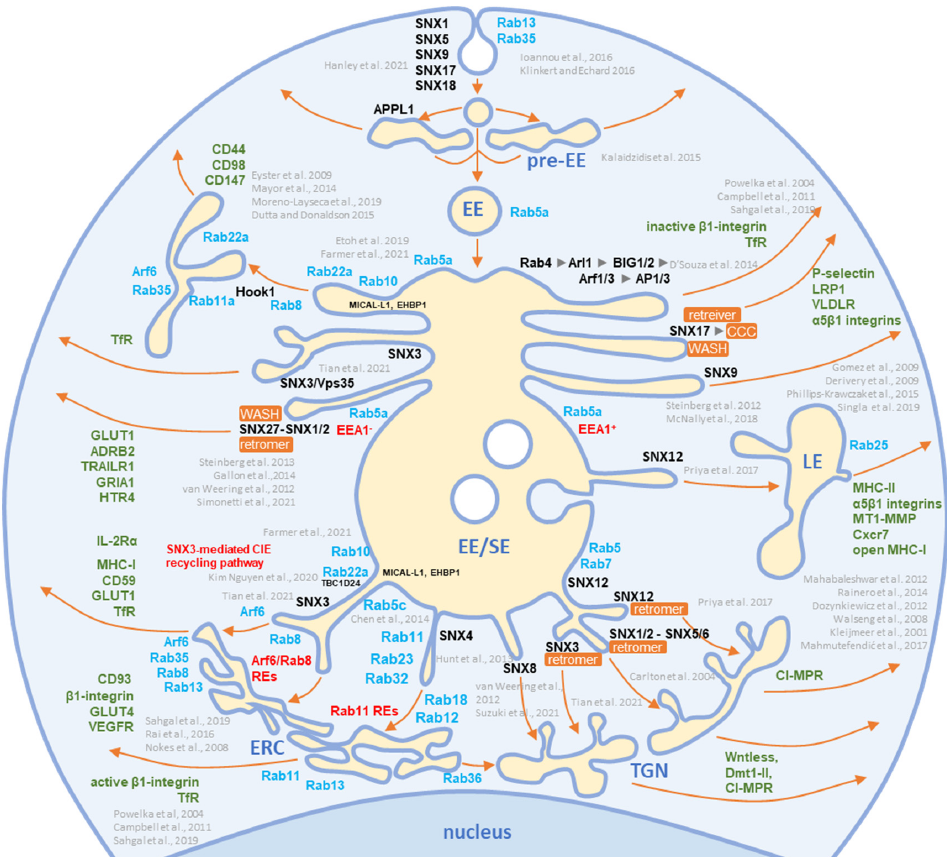
Figure 4. Schematic representation of known exit sites and recycling pathways from the early endosomal system. Cargo internalized by clathrin-dependent endocytosis (CDE) and clathrin-independent endocytosis (CIE) is collected in pre-early endosomes (pre-EEs) and either returned to the plasma membrane (PM) by rapid recycling or delivered to early endosomal (EEs) carriers. EEs undergo a series of fusion and maturation reactions that funnel cargo toward the cell center into enlarged early/sorting endosomes (EE/SE). The maturing EE/SEs sort transported cargo into tubular extensions forming a tubular endosomal network (TEN) that transports cargo directly to the plasma membrane (PM) for recycling, to pericentriolar clusters of tubular endosomes known as the endosomal recycling compartment (ERC) for indirect recycling to the PM, to the trans-Golgi network (TGN) for retrograde transport, or to late endosomes (LEs). EE/SEs also sort cargo by reverse budding into intraluminal vesicles (ILV). Upon completion of the sorting reactions, the remnants of EE /SEs enriched in ILVs become multivesicular endosomes (known as multivesicular bodies, MVBs), which undergo further LE maturation events and either fuse with lysosomes (degradation pathway) or release ILVs as exosomes (exosomal pathway). Cargo sorting into the tubular extension involves the complex and orchestrated recruitment of cellular proteins of the Rab and Arf families, their GEFs and GAPs, members of the sorting nexin (SNX) family, sorting complexes (i.e., retromer, retriever, CCC, and WASH), and other effector proteins required for endosomal tubulation and scission of transport carriers (e.g., dynamins, EHD proteins, AP complexes). The complex cascade of their recruitment is not yet fully elucidated, and the known locations in the EE/SE biogenesis are shown in the schematic. Rab and Arf family proteins are marked in blue, SNXs in black, and cargo molecules in green. Based on references